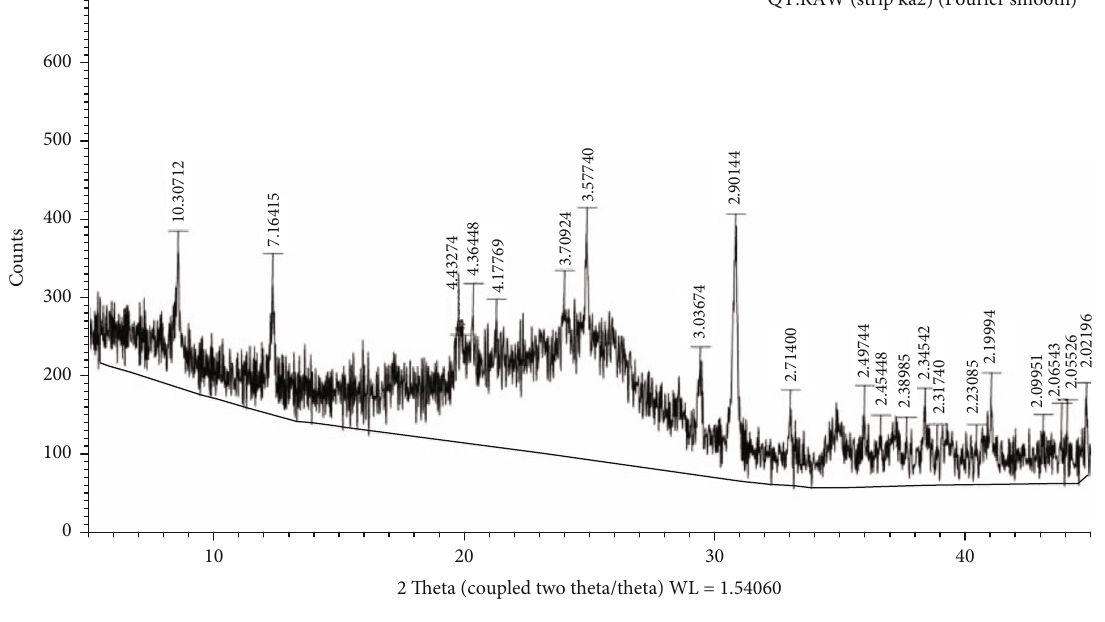
Figure 2: XRD result of A1 core plug.